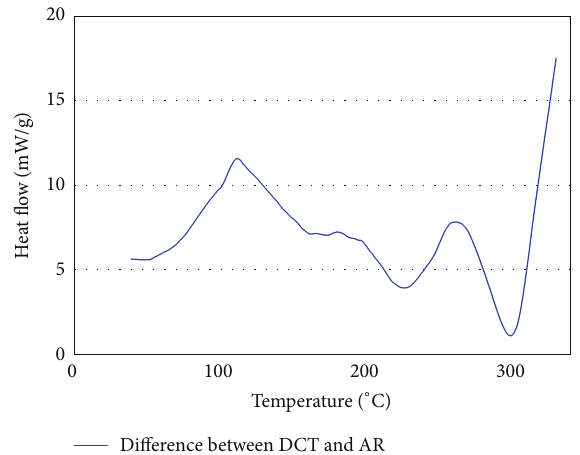
Figure 13: Differential scanning calorimetry (signal of the CTed sample with the AR material as